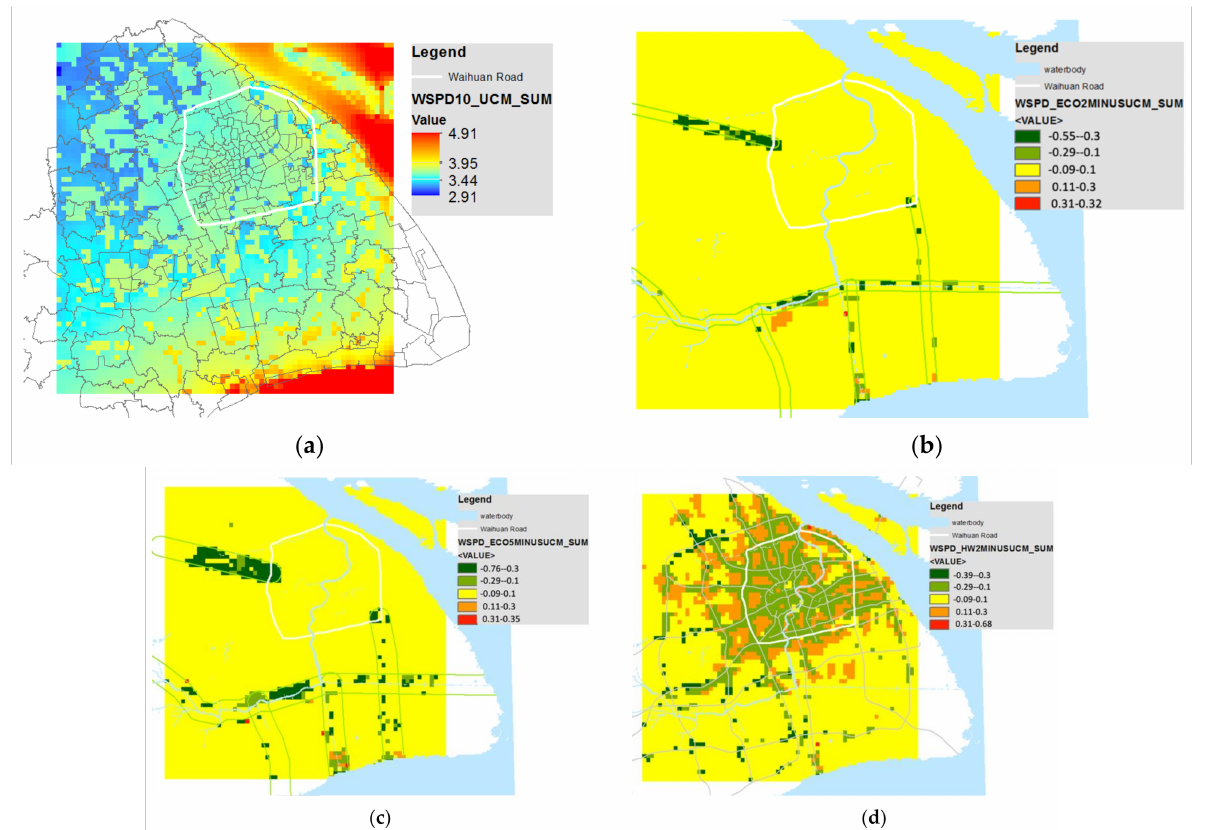
Figure 6. ( a ) Modeling wind speed at 10 m high (m/s) in summer 2014; ( b ) modeling wind speed differences at 10 m high (m/s) in the ECO02 scenario and base scenario; ( c ) modeling wind speed differences at 10 m high (m/s) in the ECO05 scenario and base scenario; ( d ) modeling wind speed differences at 10 m high (m/s) in the HW02 scenario and base